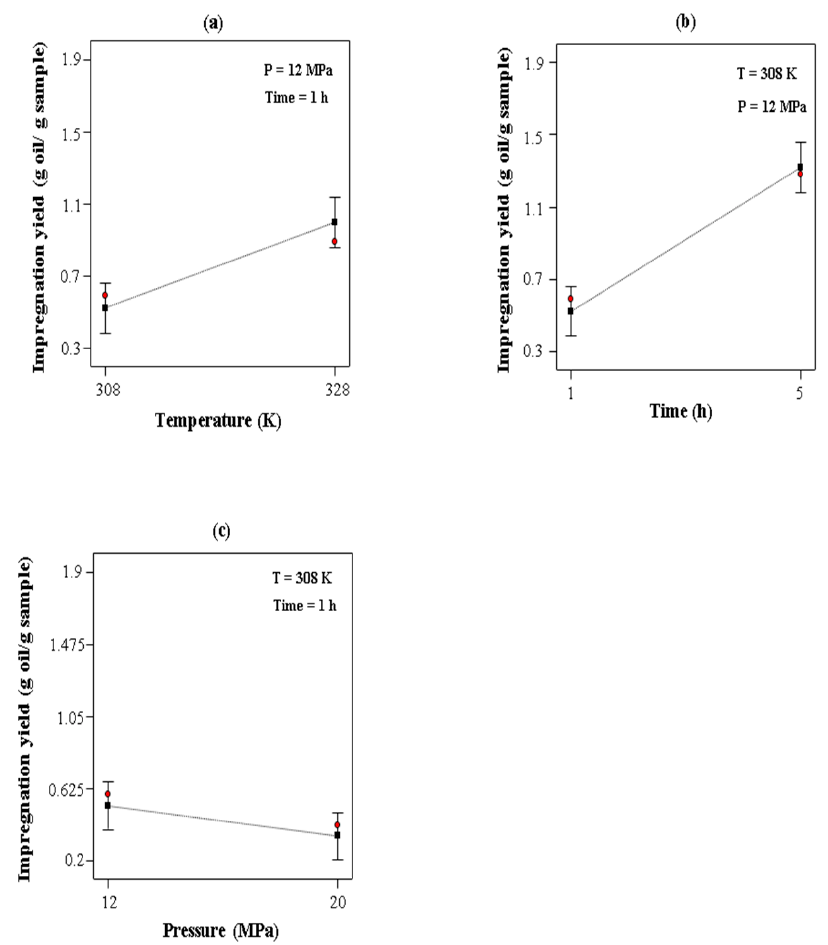
Figure 6. The effect of ( a ) temperature at a constant pressure of 12 MPa and impregnation time of 1 h ( b ) time at a constant pressure of 12 MPa and temperature of 308 K, and ( c ) pressure at a constant temperature of 308 K and time of 1 h, on the loading of rosemary essential oil in LLDPE films.